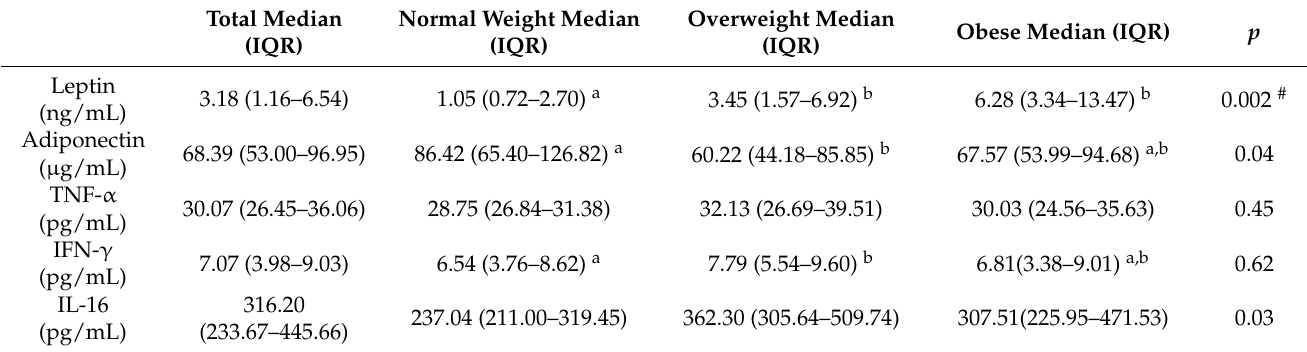
Table 4. Comparison of leptin, adiponectin, and serum cytokine levels between different